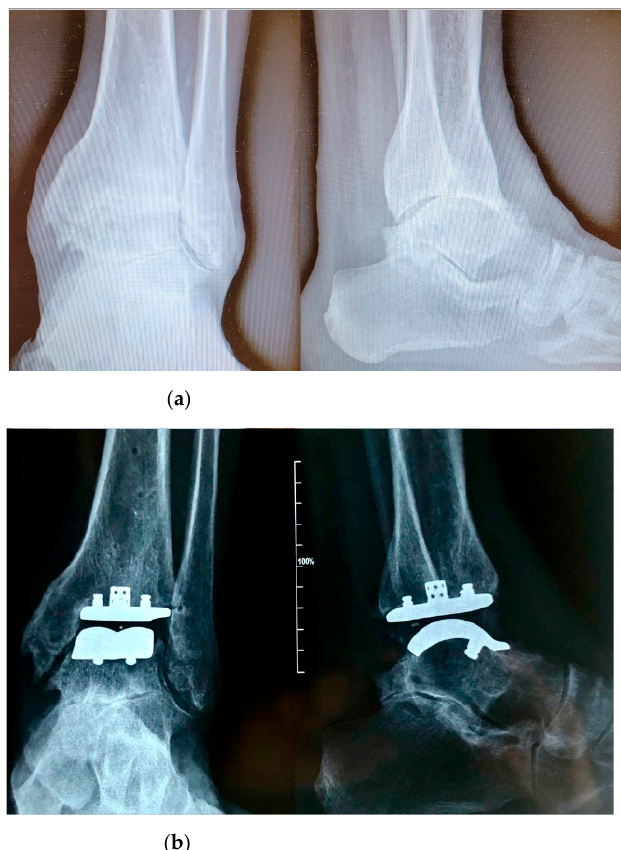
Figure 1. Pre-operative radiographic image in anteroposterior and lateral view (on the left and on the right, respectively) of an arthritic ankle joint, with a slight articular varus deformity ( a ) and post-operative radiographic results ( b ).